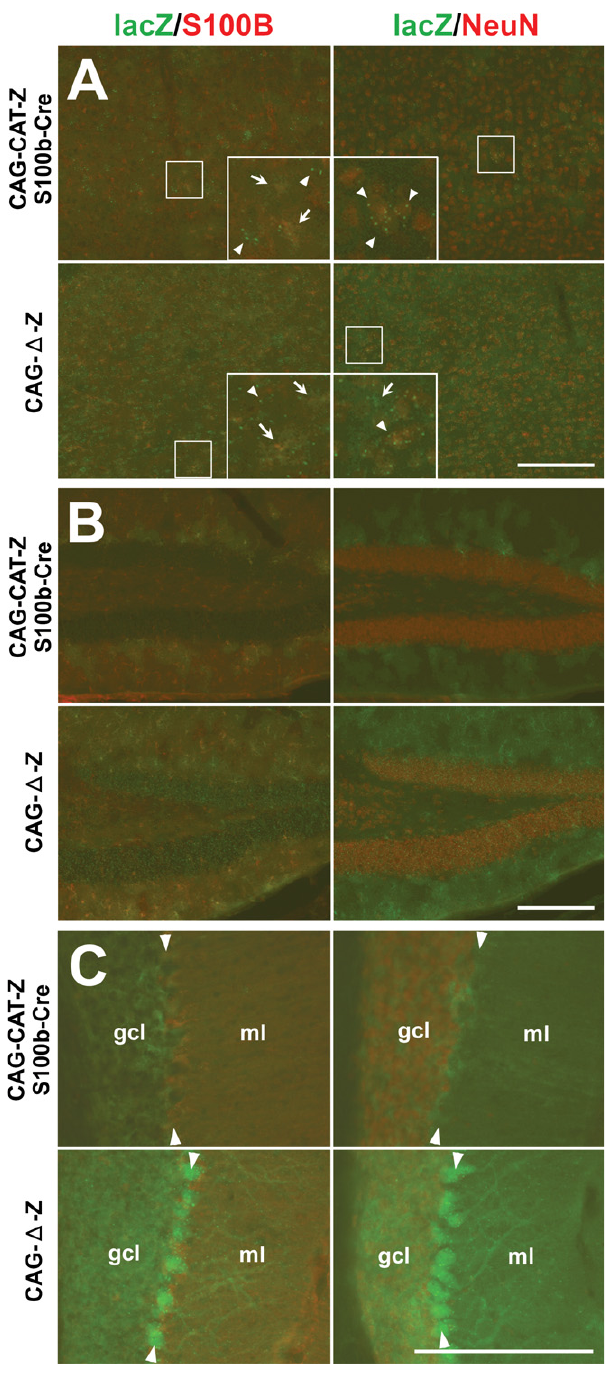
Figure 3. Cell-type specifi city of S100b-Cre -mediated recombination in CAG-CAT-Z:S100b-Cre mice. (A–C) Double-immunofl uorescence analysis of parasagittal sections from CAG-CAT-Z:S100b-Cre and CAG- Δ -Z (positive control) mice using antibodies directed to β -galactosidase (lacZ), S100B, and NeuN. Left column shows double-labeling of lacZ (green) and S100B (red), and right column shows double-labeling of lacZ (green) and NeuN (red). (A) In the cerebral cortex, lacZ immunoreactivity detected as granules (arrowheads in inserts) was localized in neurons (S100B negative and NeuN positive) in CAG-CAT-Z:S100b-Cre mice, which corresponds to the intensive lacZ staining forming a layer-like pattern in Figure 2A . In contrast, weak and/or unclear lacZ immunoreactivity (arrows in inserts) localizes in astrocytes (S100B-positive and NeuN-negative). LacZ localization both in neurons and astrocytes is less frequent in CAG-CAT-Z:S100b-Cre mice compared to that in CAG- Δ -Z. Each insert is a magnifi cation of the area indicated by the small box in the same panel. (B) LacZ was coexpressed in astrocytes (S100B-positive and NeuN-negative) in the hippocampal dentate gyrus of CAG-CAT-Z:S100b-Cre mice. LacZ/S100B colocalization was less frequent in CAG-CAT-Z:S100b-Cre compared to that in CAG- Δ -Z. (C) LacZ immunoreactivity in the cerebellum of CAG-CAT-Z:S100b-Cre mice localized in astrocytes of the granule cell layer (gcl), Bergmann glial cells in the Purkinje cell layer (arrowheads), and Bergmann glial processes in the molecular layer (ml), all of which were S100B-positive and NeuN-negative. No recombination was detected in the cerebellar granule cells (S100B-negative and NeuN-positive) or Purkinje cells of CAG-CAT-Z:S100b-Cre mice, in contrast to detectable lacZ immunoreactivity in those cells in CAG- Δ -Z mice. Scale bars, 200